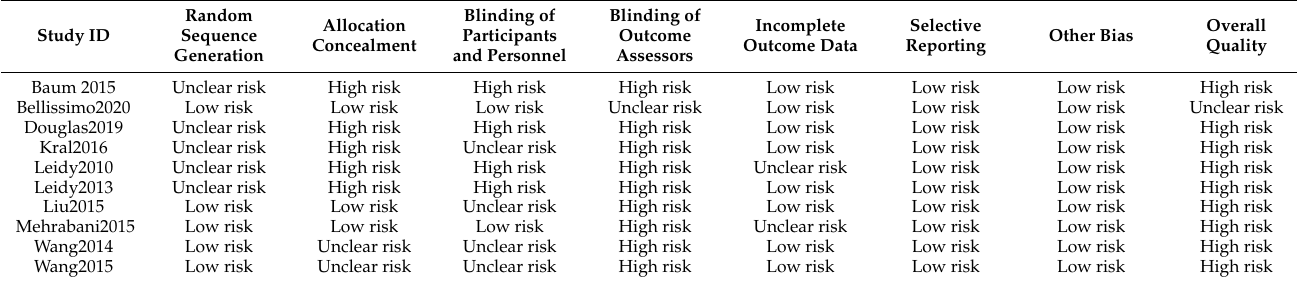
Table 4. Study quality and risk of bias assessment of included studies in the meta-analysis.